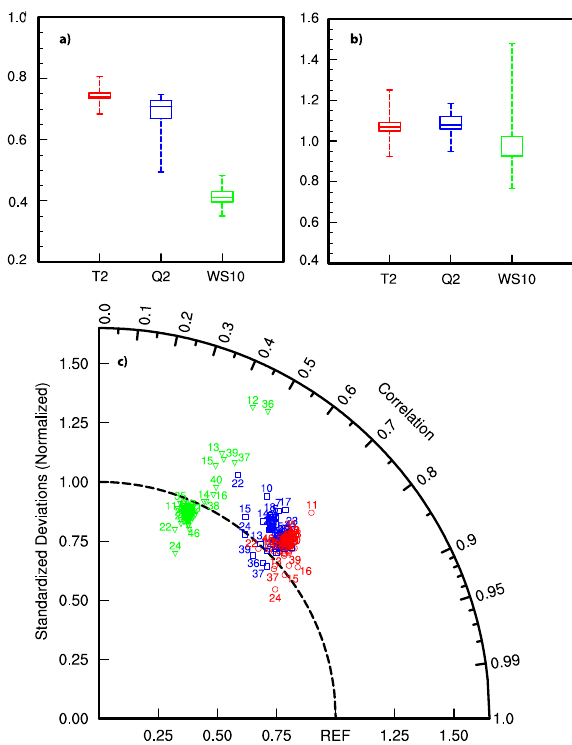
Figure 3. Same as Figure 2, but for 1–24-h forecasts.